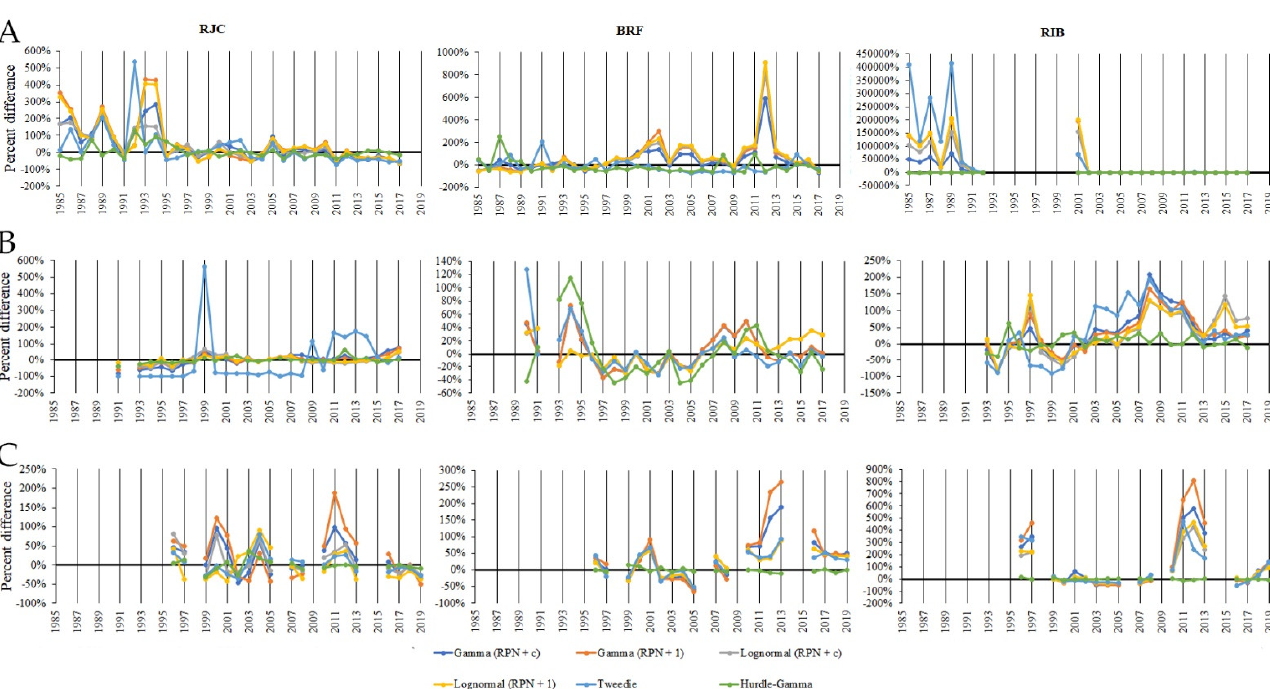
Figure 3. Percent differences between annual standardized catch rates of thornback ray Raja clavata (RJC), blackbelly rosefish Helicolenus dactylopterus (BRF), and common mora Mora moro (RIB) based on various error distributions and those from the best one (zero line). ( A ): LPUE (kg landing − 1 vessel − 1 ); ( B ): CPUE (kg days at sea − 1 vessel − 1 ); ( C ): RPN (ind. 10 − 3 hooks). The standardized CPUE indices (Figure 3) for R. clavata from the gamma ( c and 1), lognormal ( c and 1), and hurdle–gamma models were similar, with percentage di ff erences ranging from − 1% (hurdle–gamma) to 2% (gamma + c ). The estimates from the tweedie error distribution showed greater variations, with an average di ff erence of − 6%. For H. dactylopterus , percentage differences from those estimates of standardized CPUE for the hurdle–lognormal model were less than 4% on average. However, these differences could reach about 127% in some years. For the M. moro , the hurdle– gamma model showed the lower percentage difference from the hurdle–lognormal, with an average of 6%. The other error – models had greater discrepancies, ranging from 32% (lognormal + c ) to 35% (tweedie and gamma + c ).